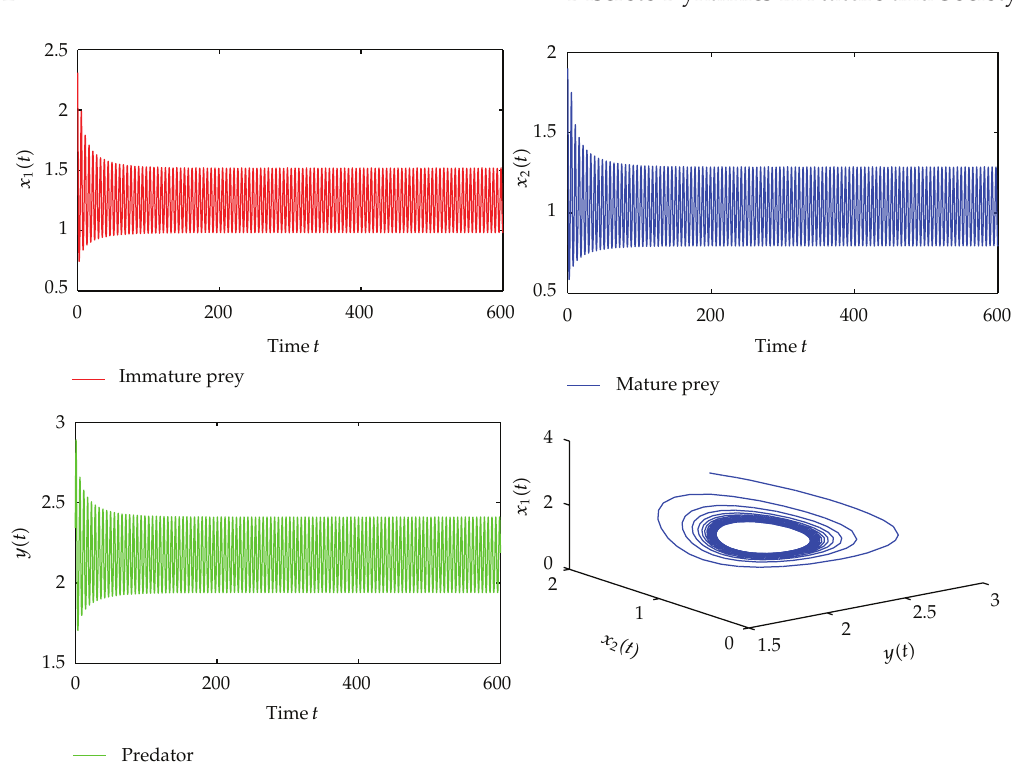
(cid:6) 0 . 6125 and τ (cid:7) (cid:6) 0 . 25 with initial value “2.31; 1.9; 2 ∗ 1 ∗